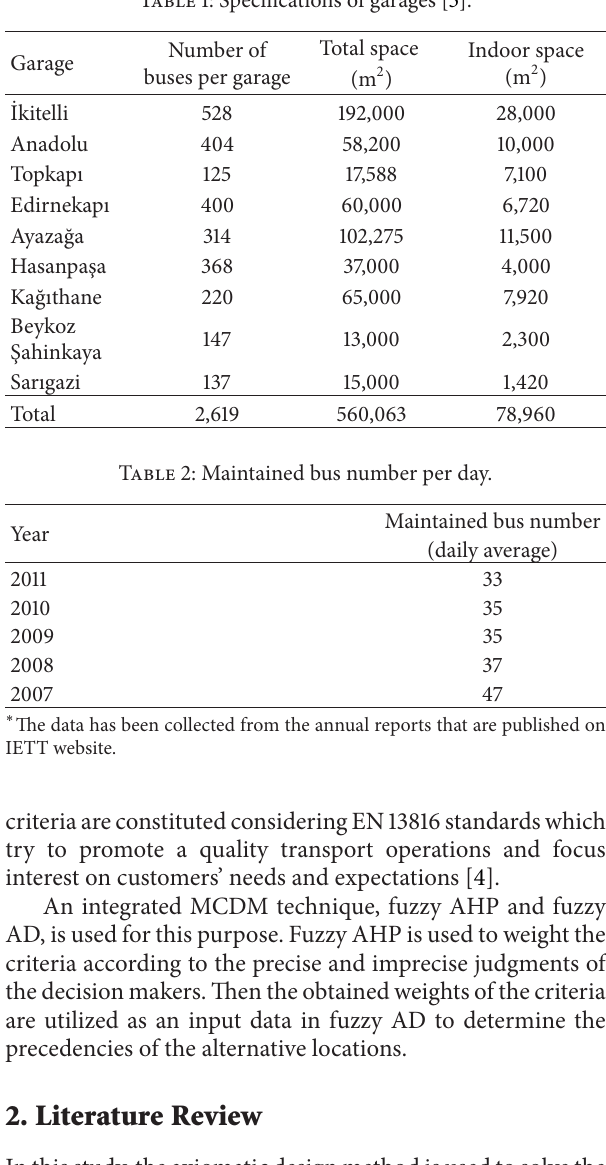
Table 1: Specifications of garages [5].